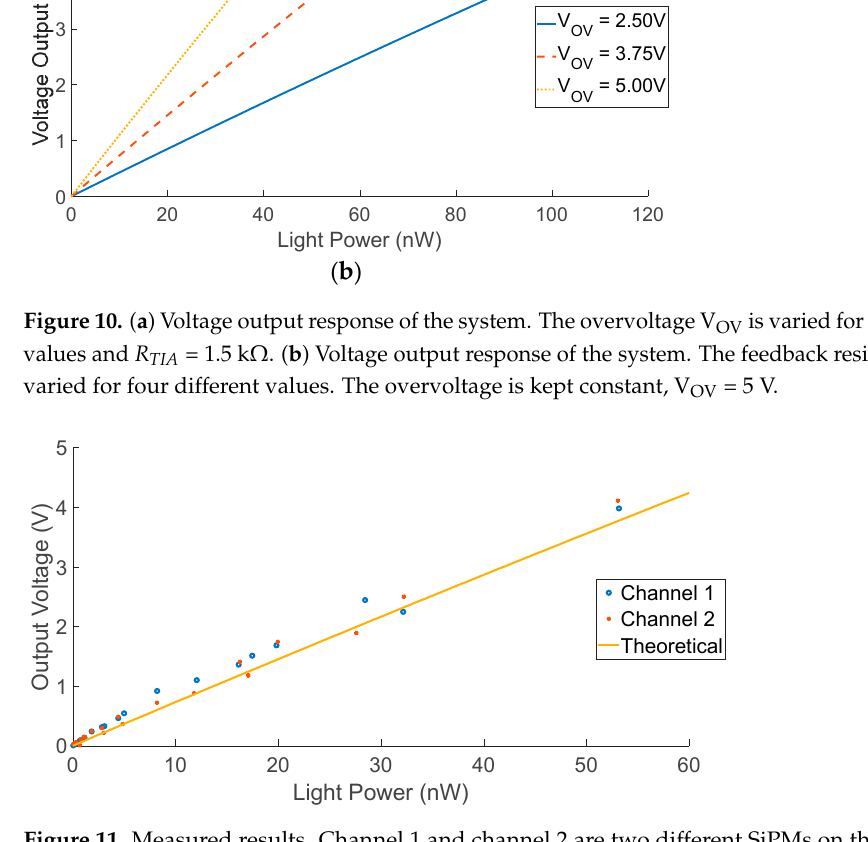
Figure 10. ( a ) Voltage output response of the system. The overvoltage V (cid:2899)(cid:2906) is varied for three dif ‐ ferent values and 𝑅 (cid:3021)(cid:3010)(cid:3002) (cid:3404) 1.5 kΩ . ( b ) Voltage output response of the system. The feedback resistance, 𝑅 (cid:3021)(cid:3010)(cid:3002) is varied for four different values. The overvoltage is kept constant, 𝑉 (cid:3016)(cid:3023) (cid:3404) 5 V .